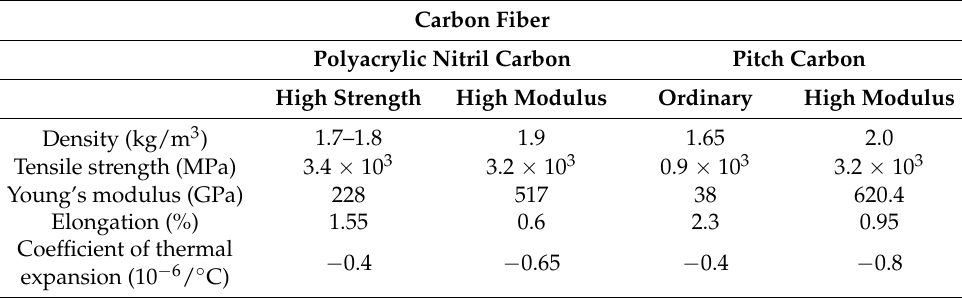
Figure 15. CFRP reinforcement cage model. ( a ) 3D view of the whole model with reinforcement; ( b ) 2D view of the model with reinforcement; ( c ) 3D view of the reinforcement cage model; ( d ) de- scription of the rebar disposition. Table 5. Typical mechanical property of carbon fiber-reinforced polymer